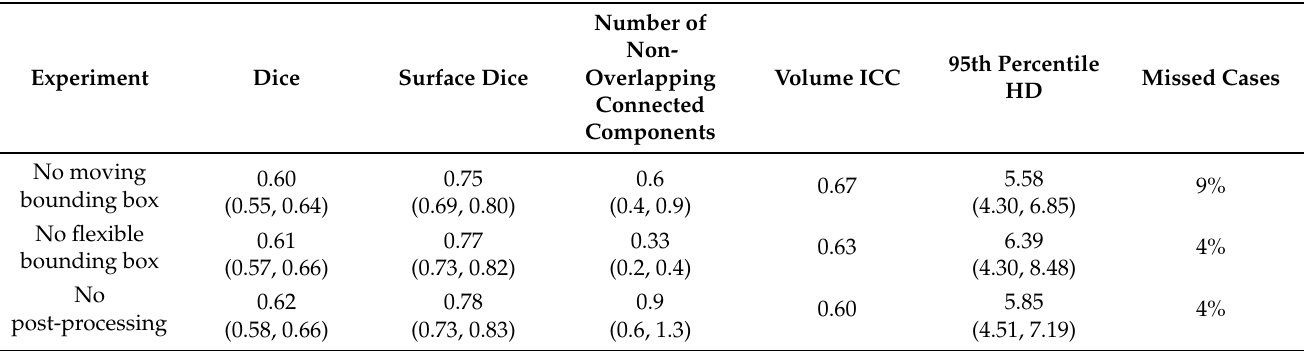
Table 4. Ablation study on the weighted-sum network. Numbers in the parenthesis show 95% confidence